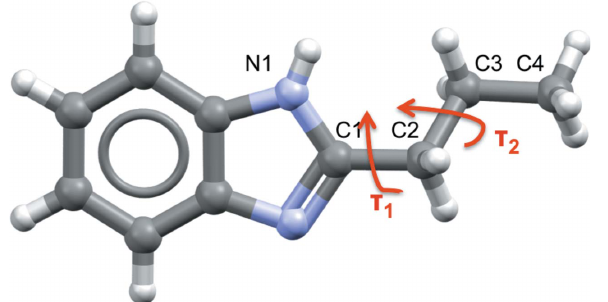
Figure 1 The molecular structure of 2PrBzIm; the torsion angles describing the conformation around the propyl chain are indicated.